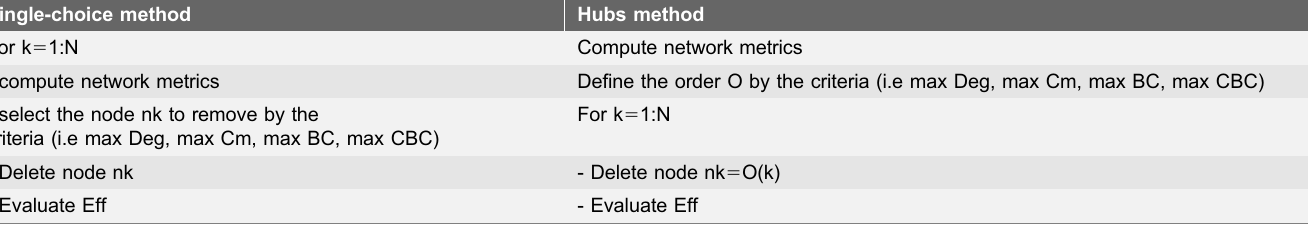
Table 3. Summary description of Single-choice method and Hubs method for the selection of the N nodes to remove (see 2.5.1). Single-choice